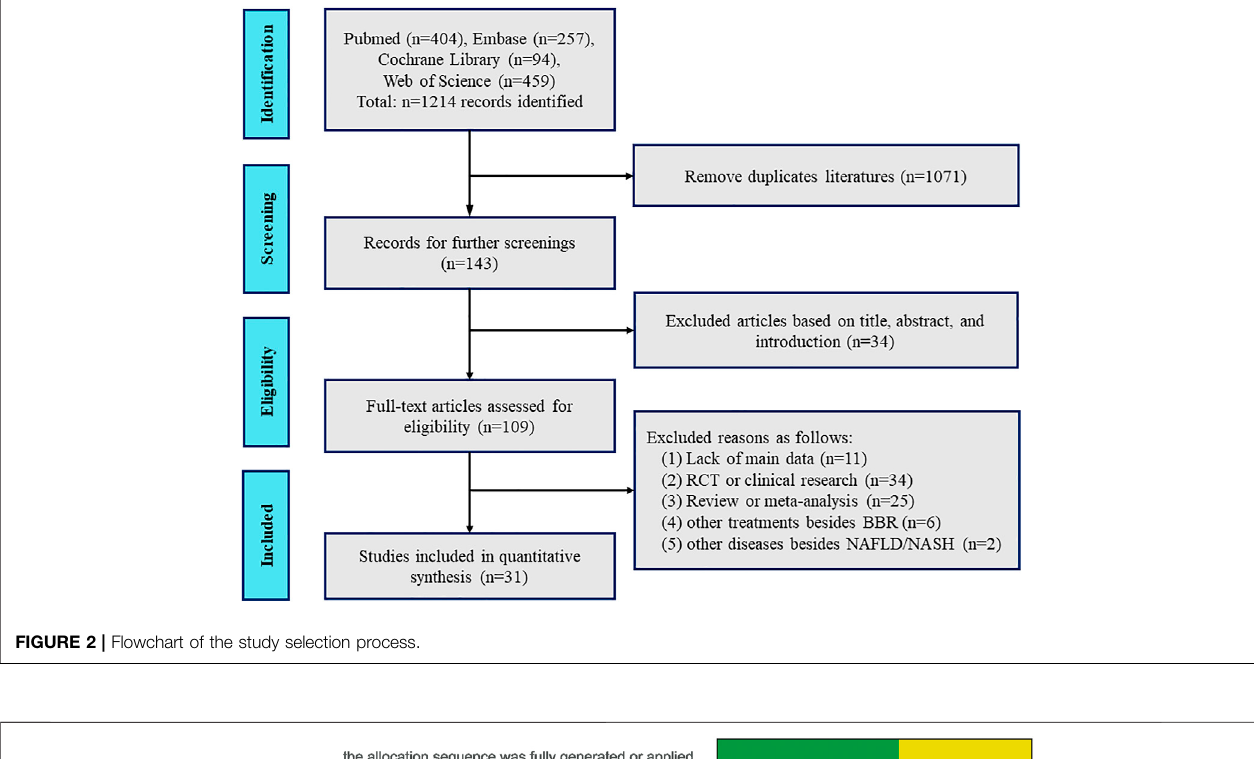
FIGURE 2 | Flowchart of the study selection process.